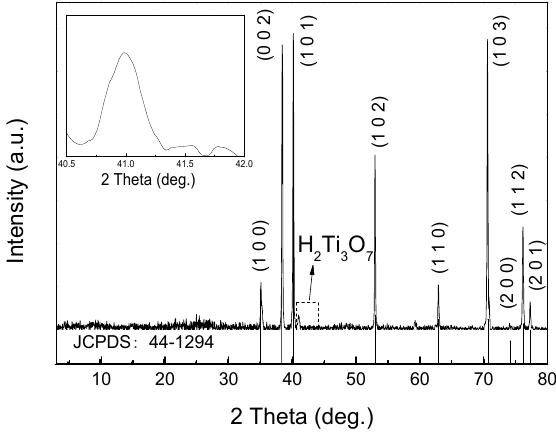
Figure 1. XRD pattern of the hydrogen titanate nanotubes (HTNTs) / Ti (inset: the curve is the enlarged XRD pattern).